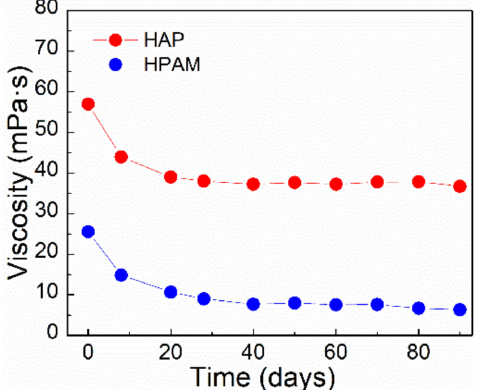
Figure 8. The long-term thermal stability of polymer solutions based on apparent viscosity over time at 75 ◦ C. (Polymer concentration, 0.175%; salinity, 3.26 × 10 5 mg/L; shear rate, 7.34 s − 1